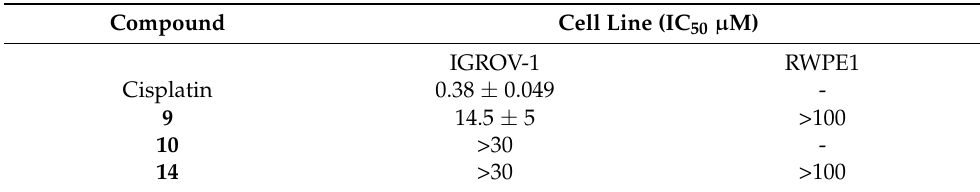
Table 1. Cytotoxic activity of kynurenic acid derivatives on human cell lines a . Cisplatin was used as positive control.